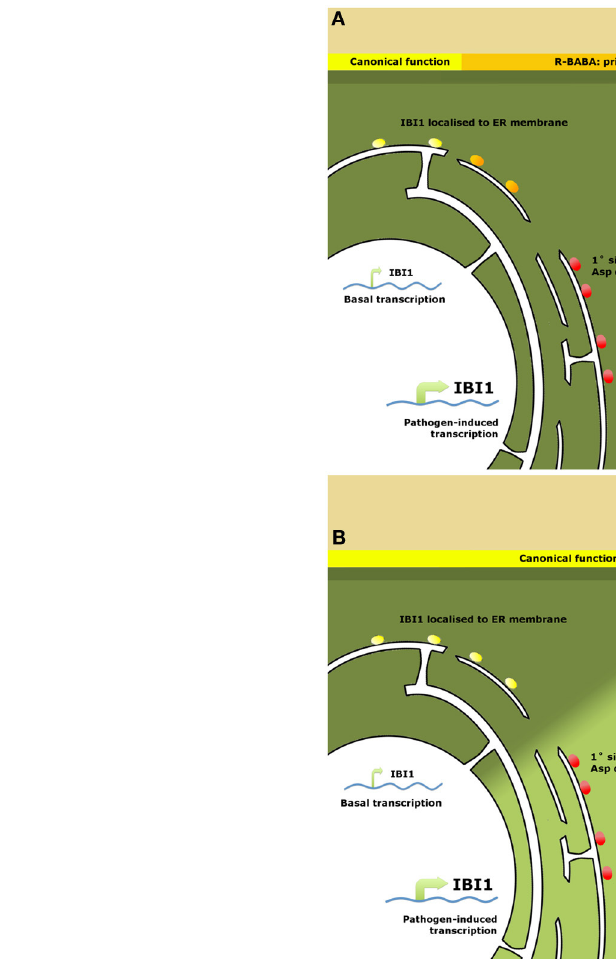
immune-regulatory proteins (red circles). (B) Role of IBI1 in basal resistance. Successful pathogen infection leads to suppression of PAMP recognition through the action of pathogen-derived effectors (blue asterisks). Ongoing parasitization and amino acid uptake by the pathogen lowers cellular L-asp levels, depriving IBI1 from its canonical AspRS activity. This, together with effector-weakened PAMP perception, boosts IBI1 transcription and elicits translocation of the protein from the ER to the cytosol, where it activates broad-spectrum defenses (red circles). Hence, IBI1 acts as a “depleted-self” sensor to counteract effector-triggered suppression of “nonself